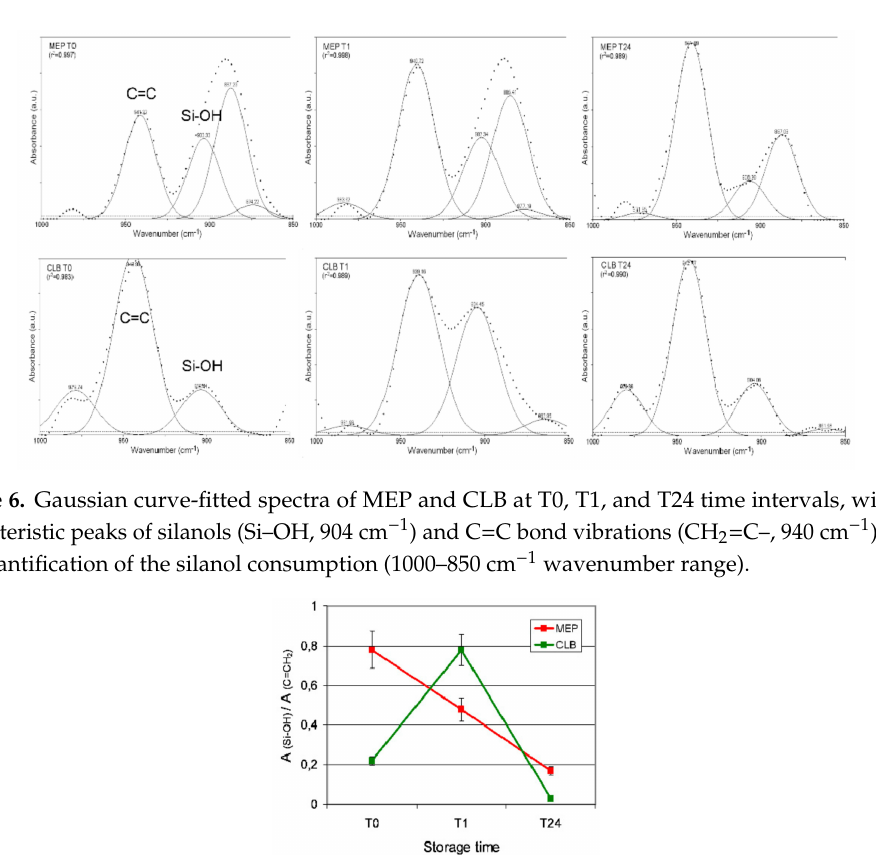
Figure 7. The normalized silanol consumption rate in MEP and CLB as a function of storage